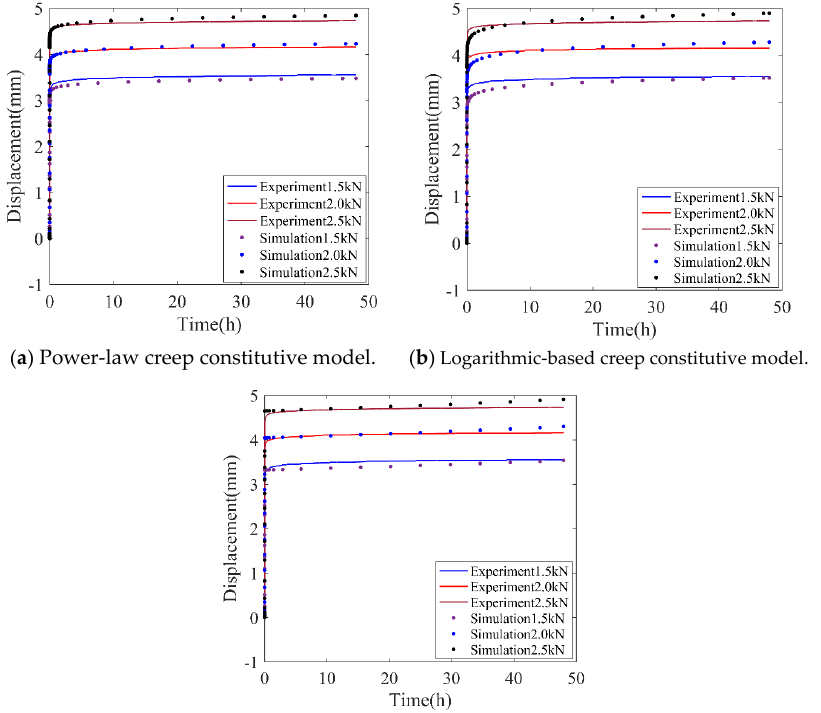
Figure 11. Comparison of creep deformation between numerical and experiment results ( T = 23 °C).